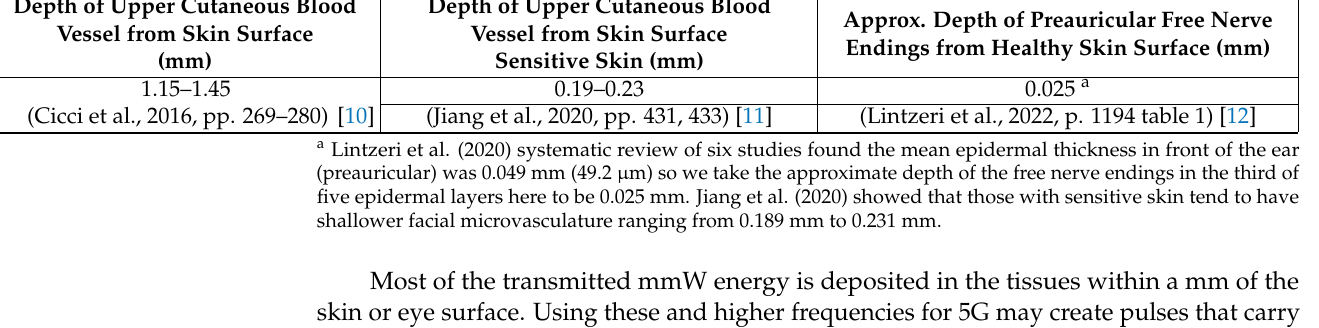
Table 1. Average depth microvasculature and free nerve endings. Depth of Upper Cutaneous Blood Depth of Upper Cutaneous Vessel from Skin Surface (mm)